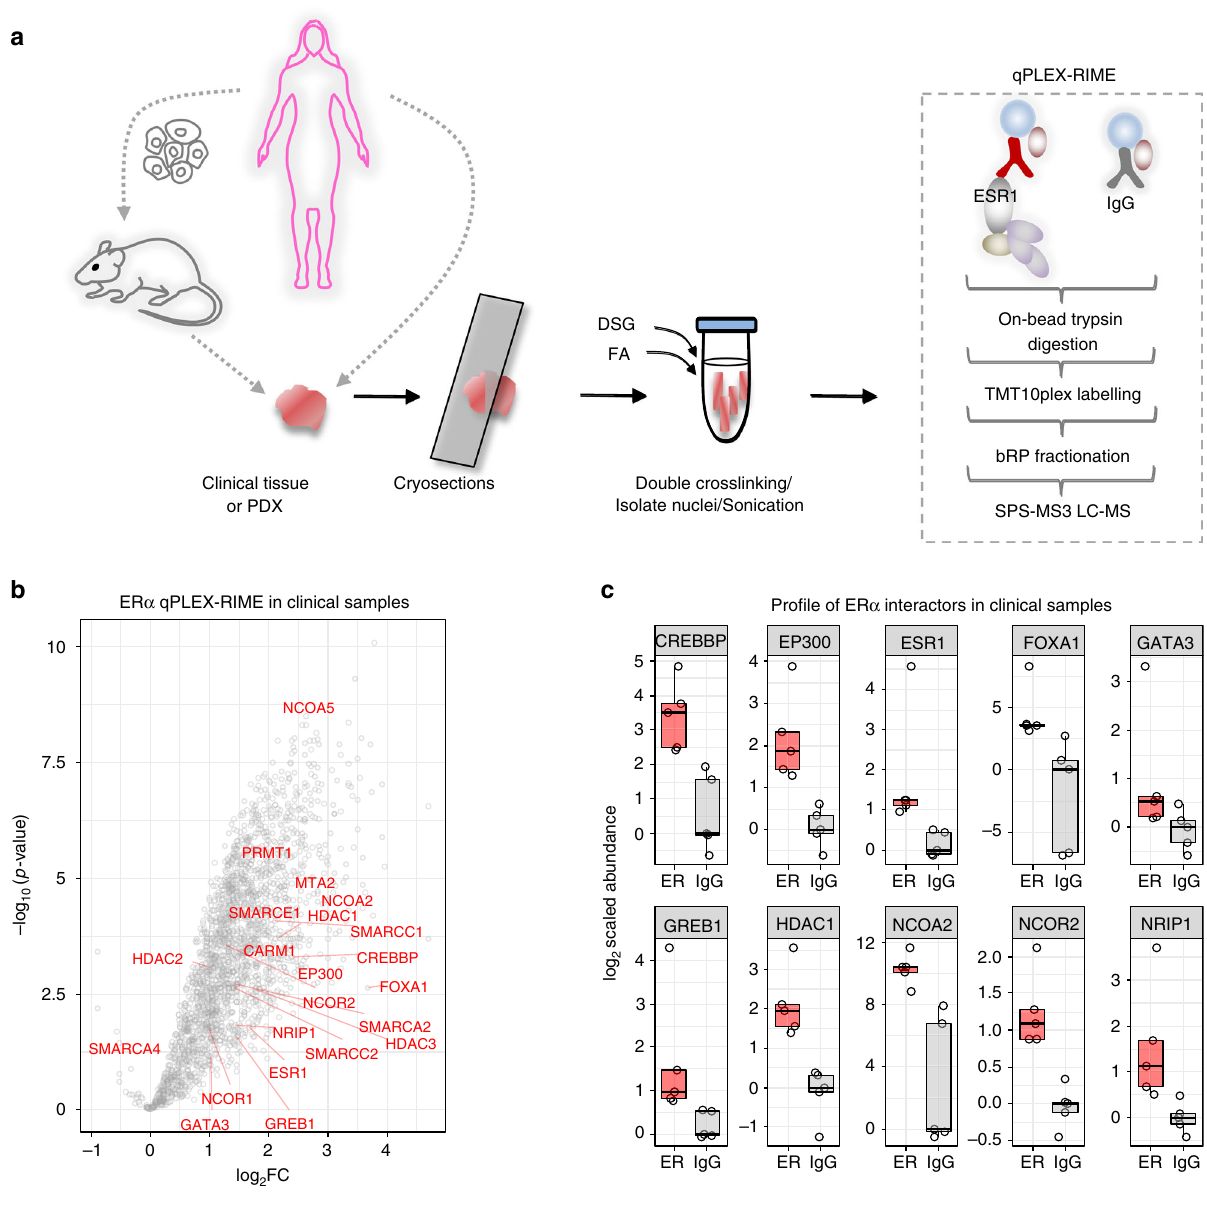
Fig. 6 Characterisation of ER α interactors from in vivo samples. a Schematic representation of the ER α qPLEX-RIME work fl ow in human xenograft tissues or in human breast cancer tumours. b Volcano plot summarising the quantitative results of the ER α interactome in human breast cancer tumours. Several well-known ER α interactors are labelled. c Boxplots illustrating the enrichment of selected known ER α interactors in the ER α samples compared to IgG controls in human breast cancer tissues. The log 2 values are normalised so that the median of IgGs is zero. Centre line shows the median, bounds of box correspond to the fi rst and third quartiles and the upper and lower whiskers extend to the largest or the smallest value no further than 1.5 × IQR (inter- quartile